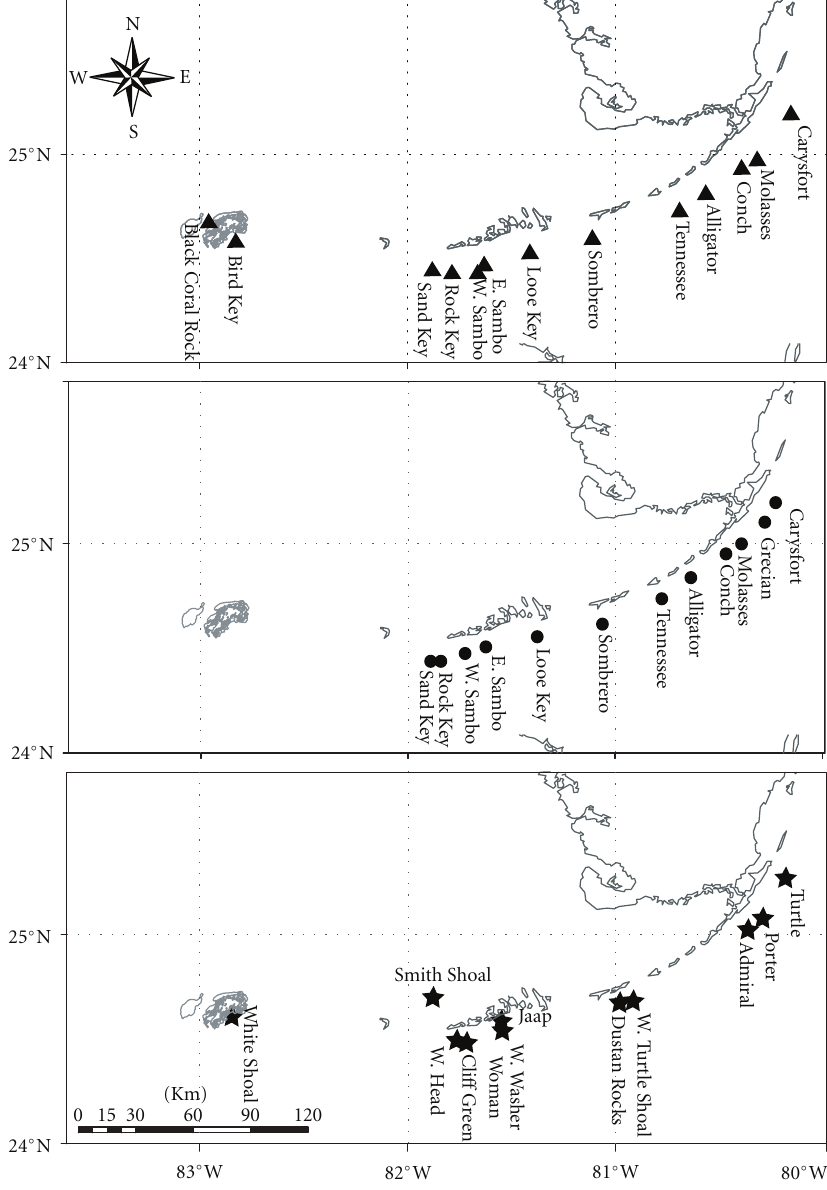
Figure 1: Location of the CREMP sites in the Florida Keys National Marine Sanctuary. (Top panel) o ff shore deep reefs; (middle panel) o ff shore shallow reefs; (bottom panel) patch